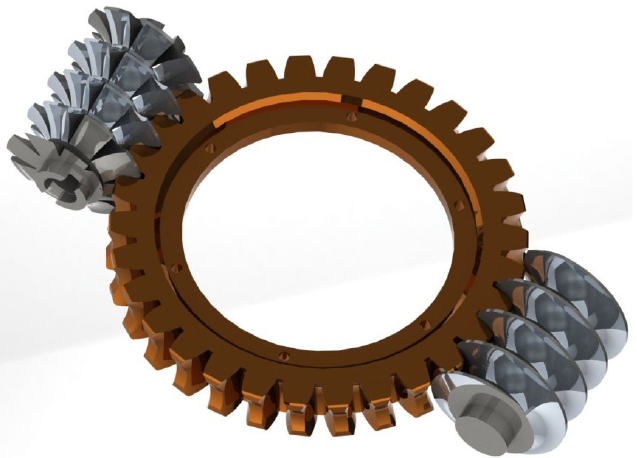
Figure 2. The worm gear drive and the hob derived from the worm [17]. The geometrical parameters of the worm profile, such as the radius of the circle arc ρ ax , the distance between the worm axis and the center of the profile circle K are shown in Figure 3.